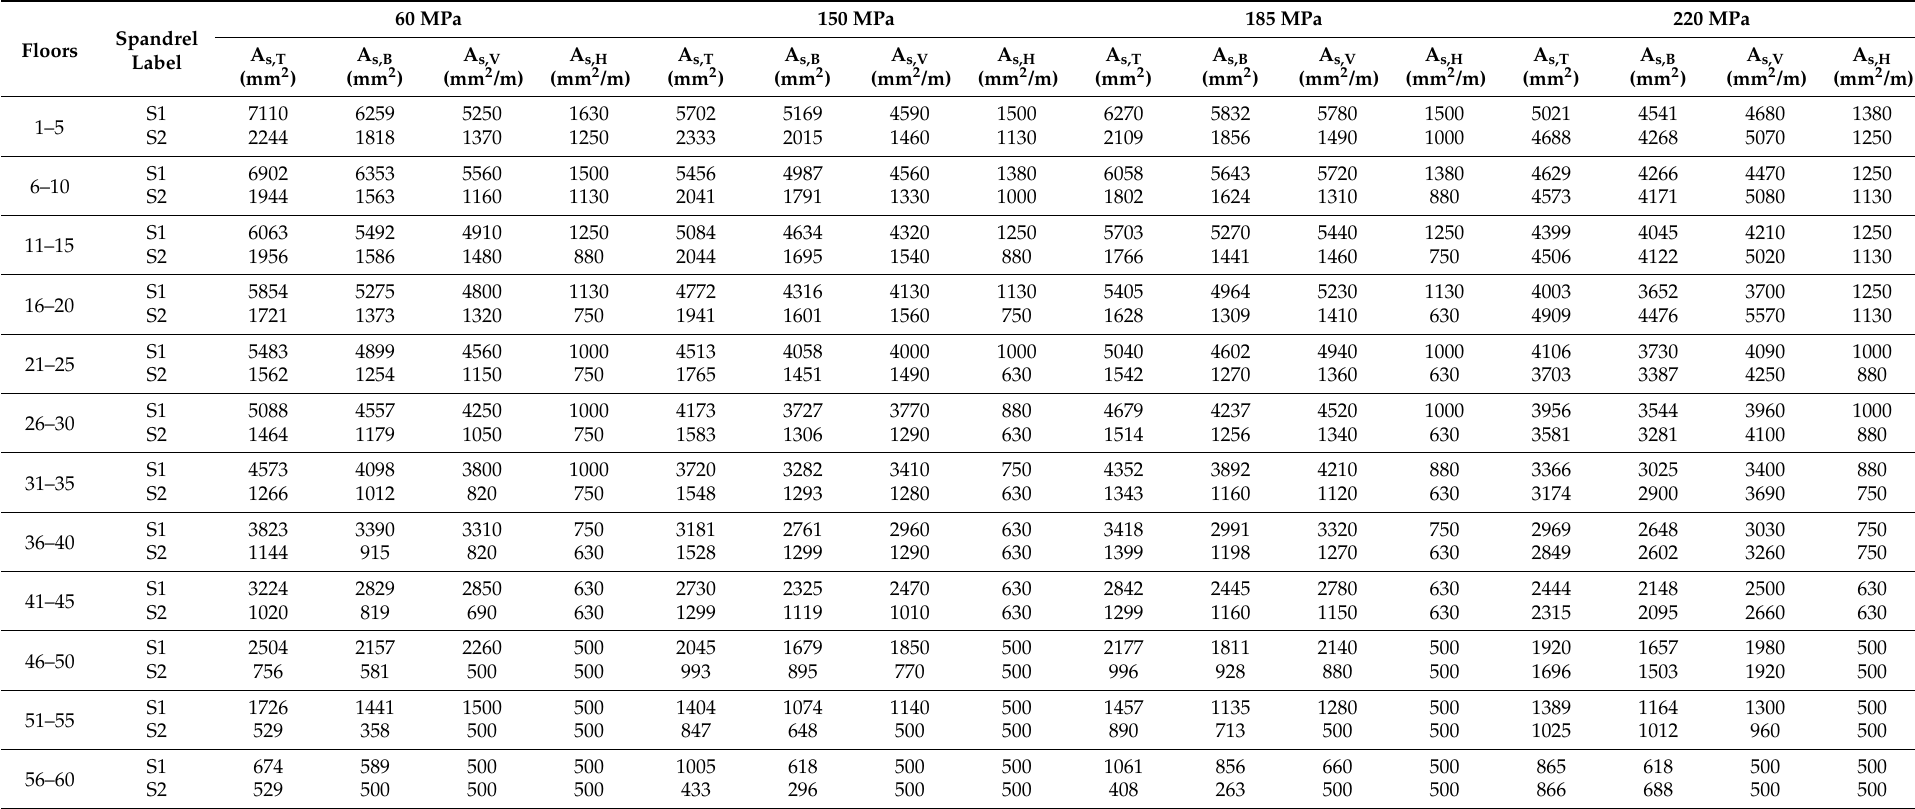
Table 6. Spandrels design